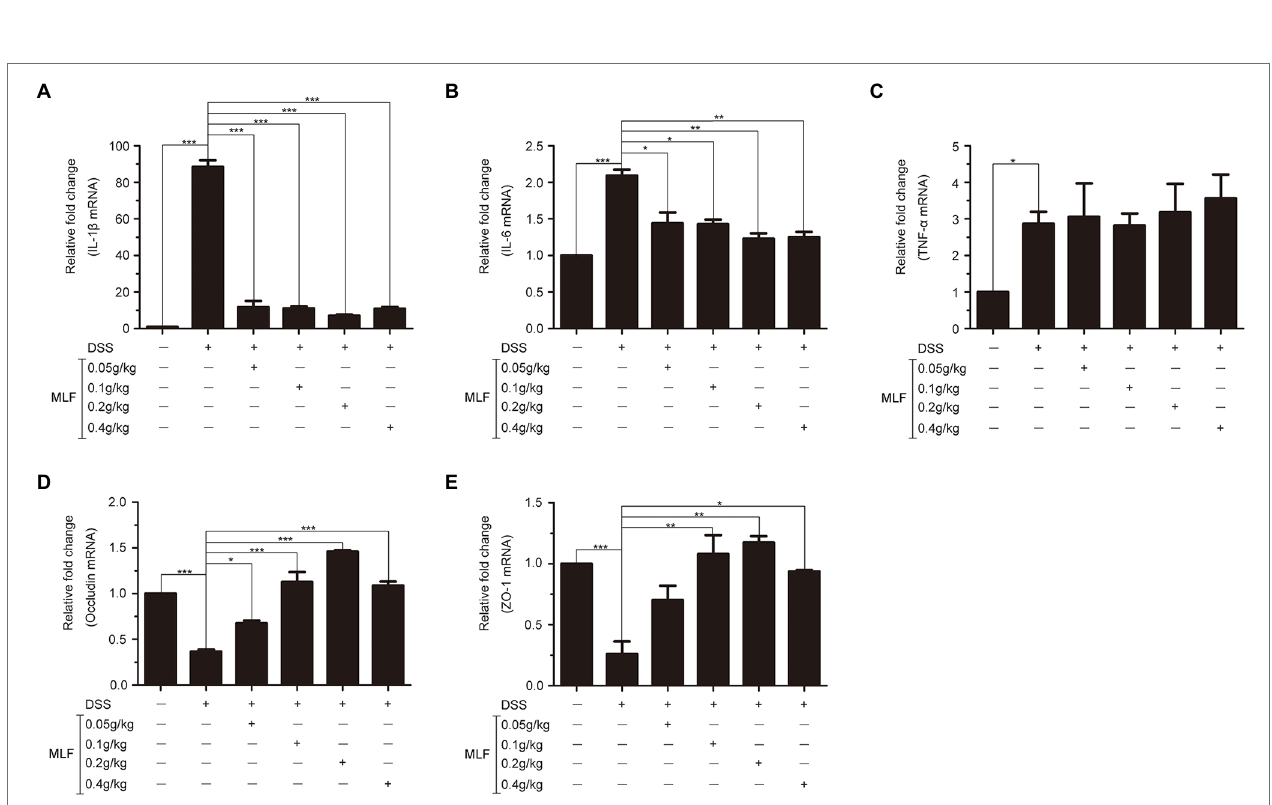
FIGURE 6 | Effects of MLF on the levels of IL-1 β , IL-6, and TNF- α . The levels of IL-1 β (A) , IL-6 (B) , and TNF- α (C) in serum of DSS-induced UC mice were detected using ELISA Kits. MLF groups were statistically analyzed with the DSS group. Data are expressed as means ± S.E. * p < 0.05 and ** p < 0.01.